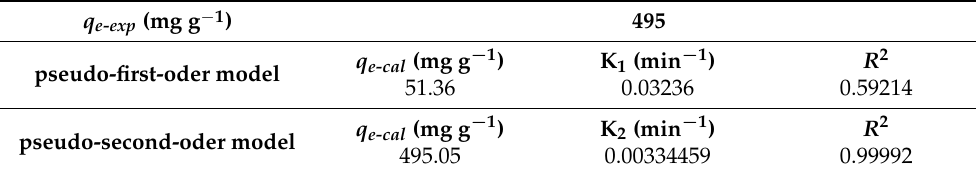
Table 10. Kinetic parameters for adsorption of CR on the HPMA powder.